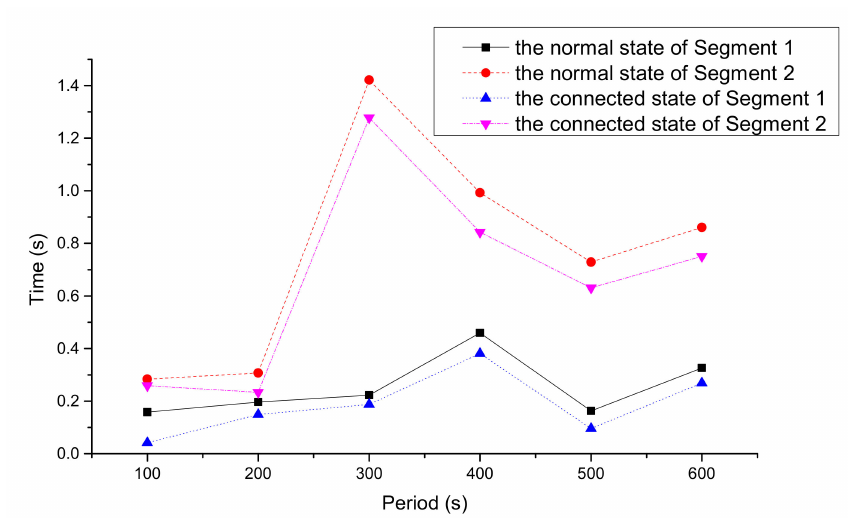
Figure 9. Average delay time in two